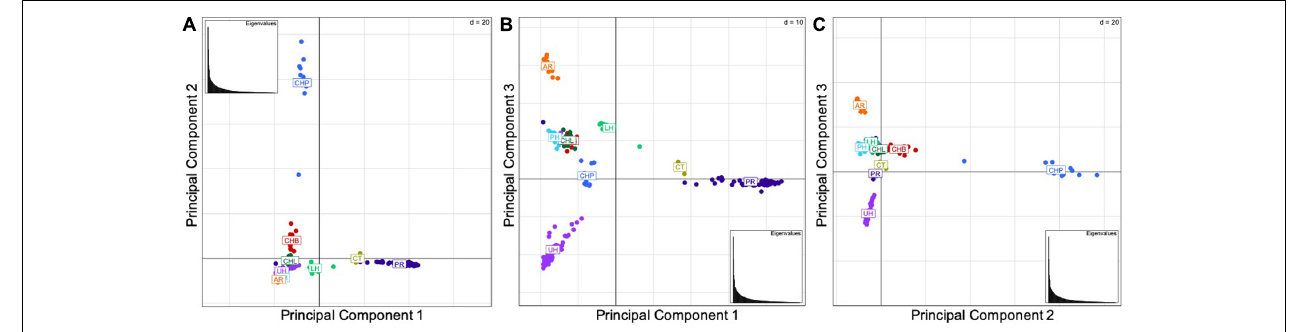
FIGURE 2 | (A) Components 1 and 2, (B) Components 1 and 3, (C) Components 2 and 3. Principal component analyses by locality. The abbreviations are as follows: CHB, Bohu Lake, China; CHL, Liangzi Lake, China; CHP, Poyang Lake, China; AR, Arkansas; CT, Chinatown, Manhattan; LH, Lower Hudson River basin; PH, Philadelphia; PR, Potomac River basin; and UH, Upper Hudson River basin. The three principal components explain 46.49% of the variation in the data